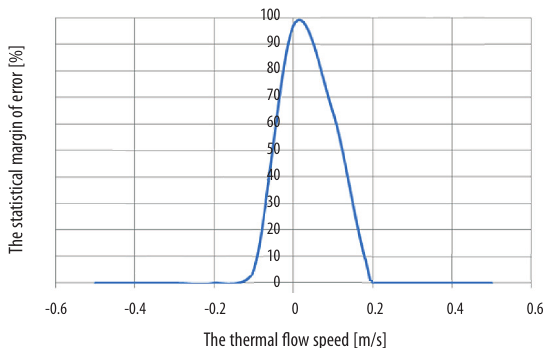
Fig. 10. Statistical margin of error detection of thermal flow when angle of attack is 2.0